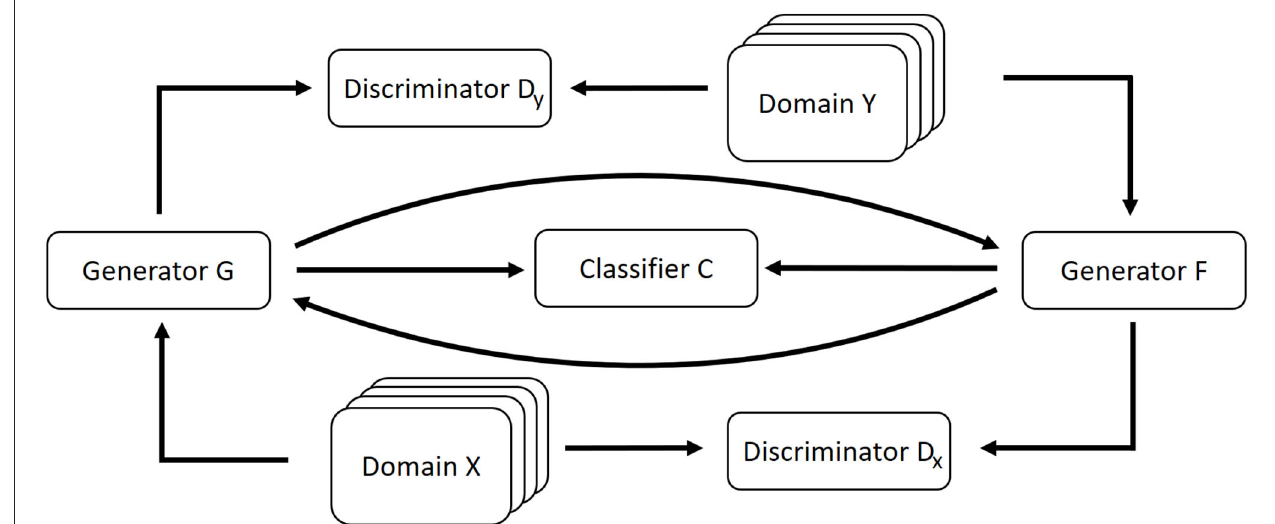
FIGURE 1 | Schematic overview of our approach. A CycleGAN architecture is extended with the classifier that shall be explained. Both the generators of the CycleGAN include the classifier’s decisions for the generated data into their loss function.